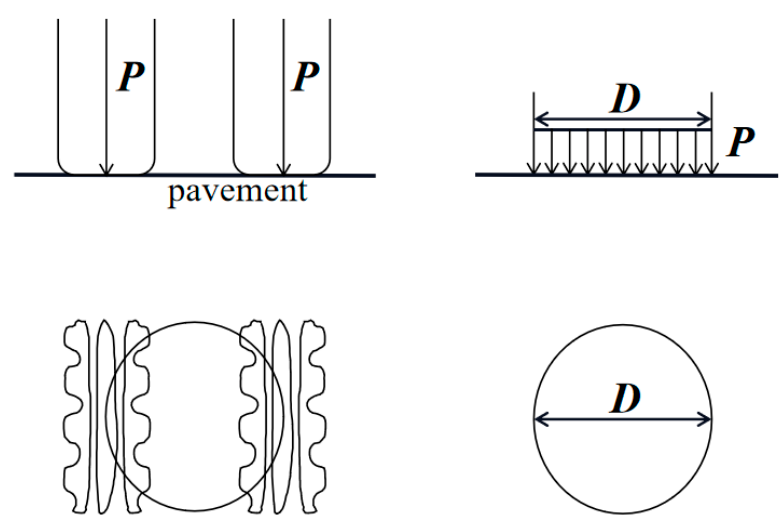
Figure 4. Contact surface between tire and ground.